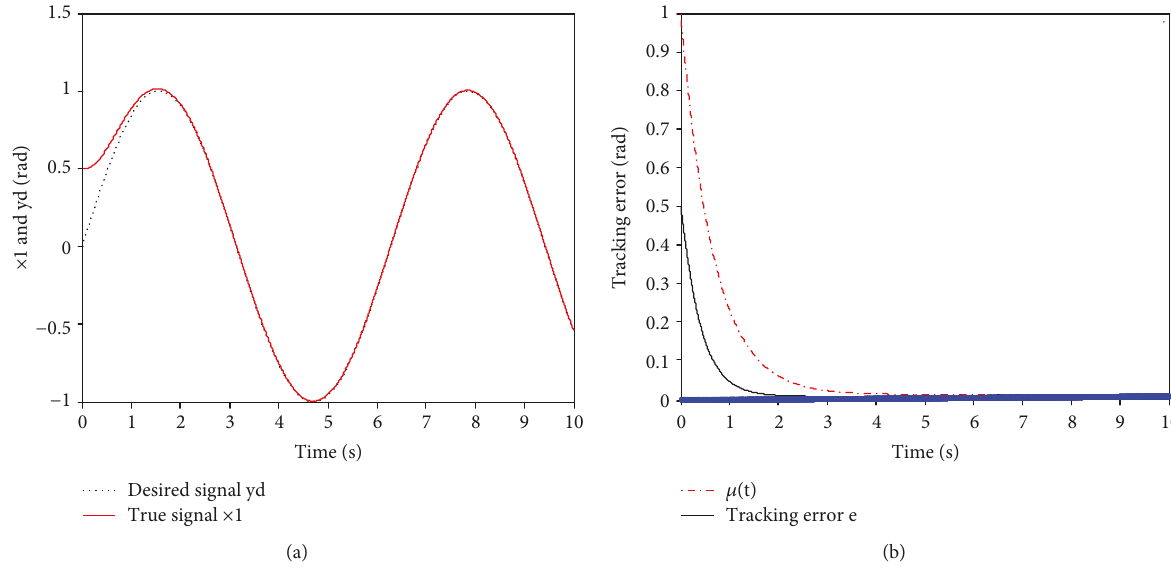
= 0 01 , δ = 0 05 , γ = 100 , and ∞ = x − y 1 d .